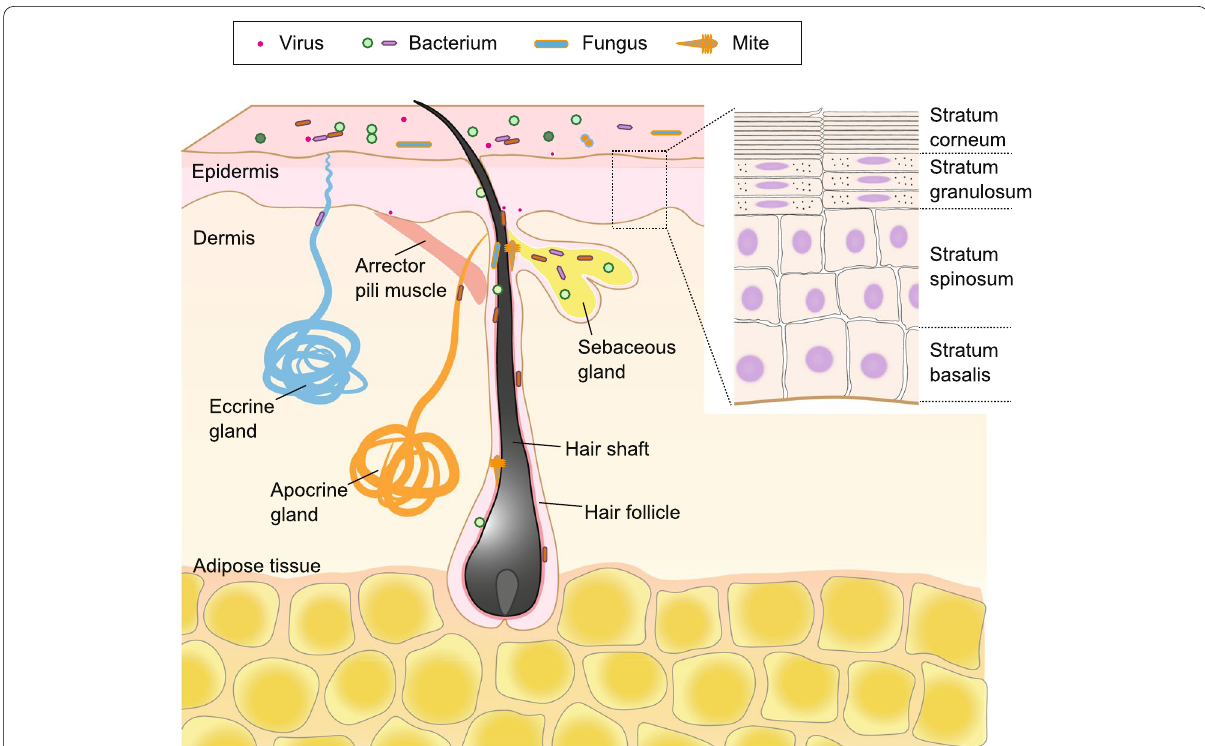
Fig. 1 Structure of the skin and microbiota. The skin is the outermost barrier that covers the entire body and provides habitats for the microbiota (viruses, bacteria, fungi, and mites). The skin consists of epidermis, dermis, and adipose tissue. The epidermis is divided into four layers: stratum basalis, stratum spinosum, stratum granulosum, and stratum corneum, from the basal side to the apical side. The dermis and adipose tissue contain skin appendages, such as sweat glands (eccrine and apocrine glands), hair follicles, hair shafts, sebaceous glands, and arrector pili muscles. Eccrine glands produce sweat and open directly onto the epidermal surface through the duct, whereas apocrine glands and sebaceous glands connect to the hair follicle. The skin microbiota colonizes both the surface and appendages, and its composition varies depending on the